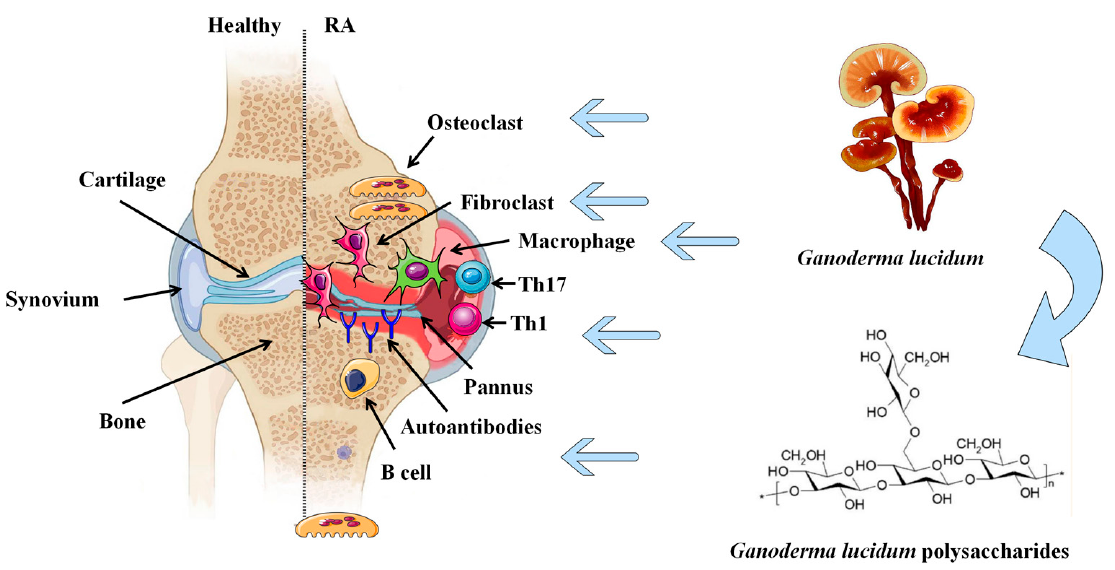
Figure 2. Potential anti-RA effects of GLP. GLP can inhibit the proliferation and migration of fibroblasts and regulate inflammatory cytokines. It exhibits immunomodulatory effects by regulating the proliferation and differentiation of T and B lymphocytes. GLP attenuates pannus formation by inhibiting the proliferation of vascular endothelial cells and promoting the formation of osteoblasts, exerting a protective effect on bone and joint cartilage. RA: rheumatoid arthritis.